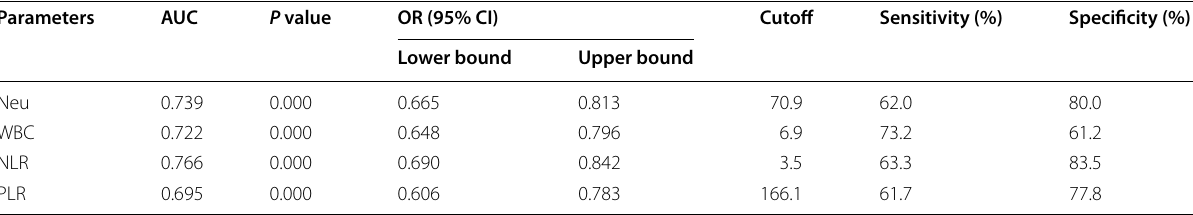
AUC, area under the curve; OR, odds ratio; Neu, neutrophils; WBC, white blood cells; NLR, neutrophil–lymphocyte ratio; PLR, platelet–lymphocyte ratio